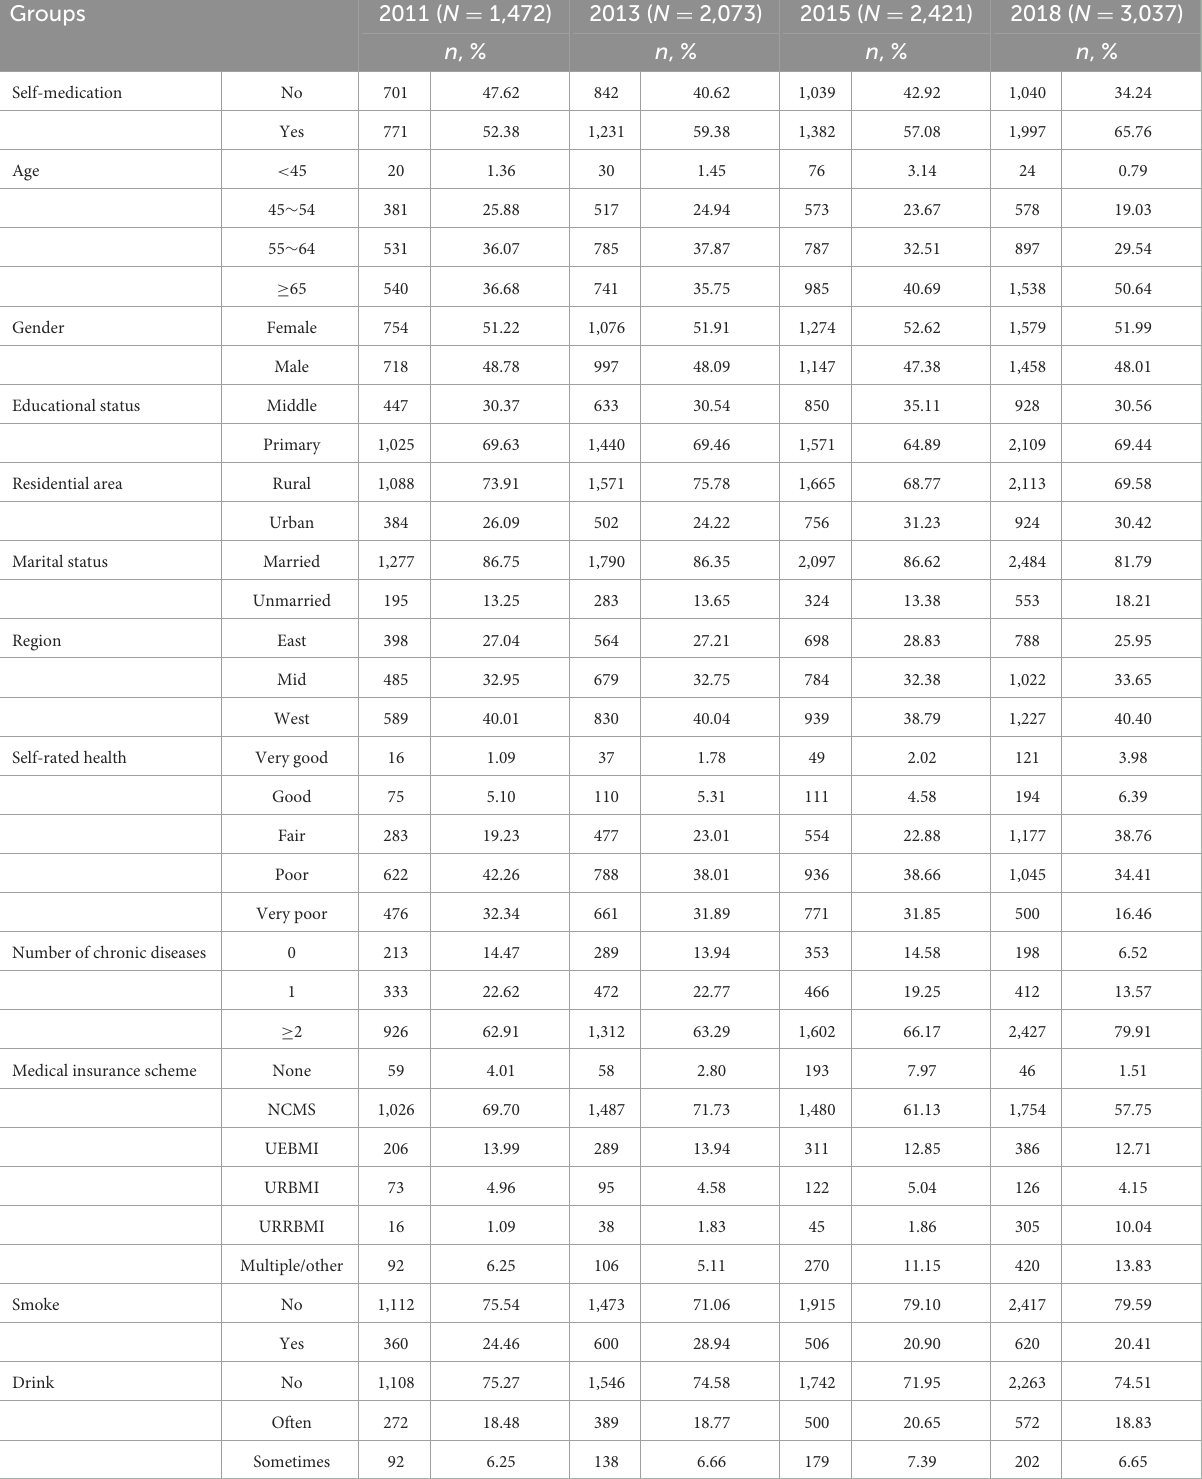
TABLE 2 Demographic characteristics of inpatients ( N = 9,003).